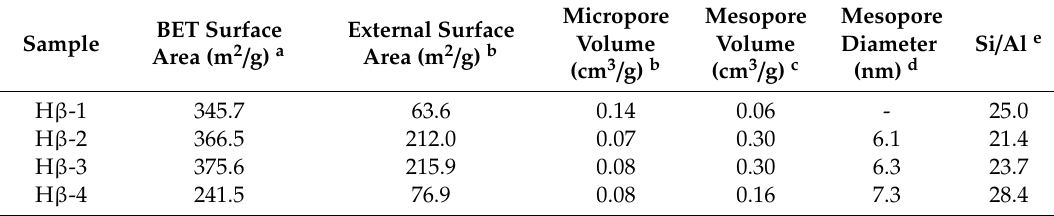
Table 1. Textural properties and chemical composition of the catalysts.